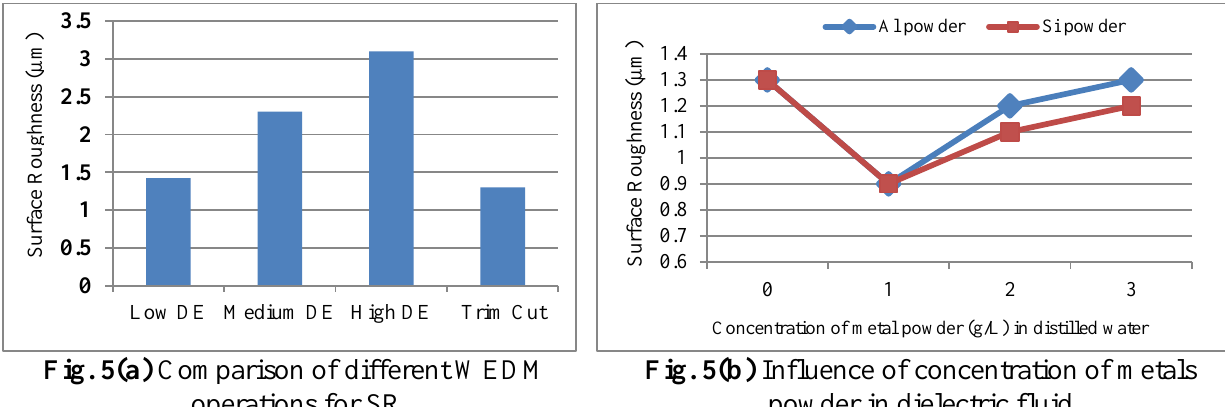
Fig. 5(a) Comparison of different WEDM operations for SR